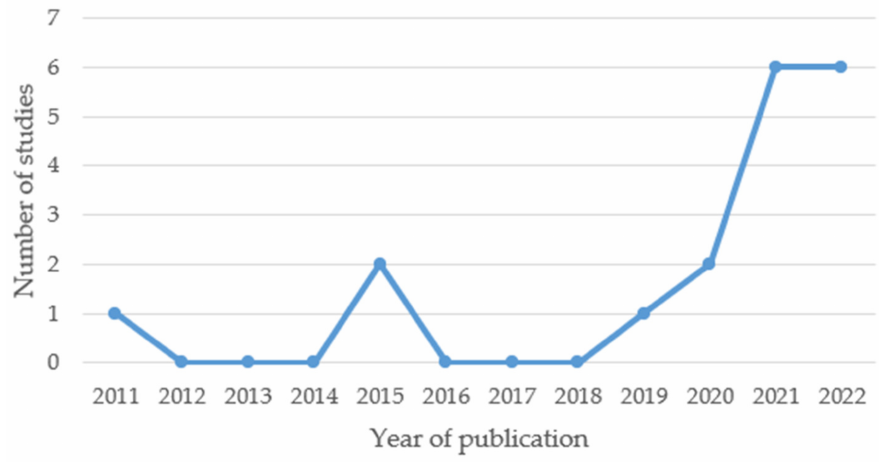
Figure 2. Years in which the included studies were